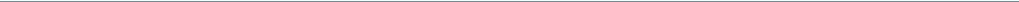
algorithm results in safe rule-out of NSTEMI (negative